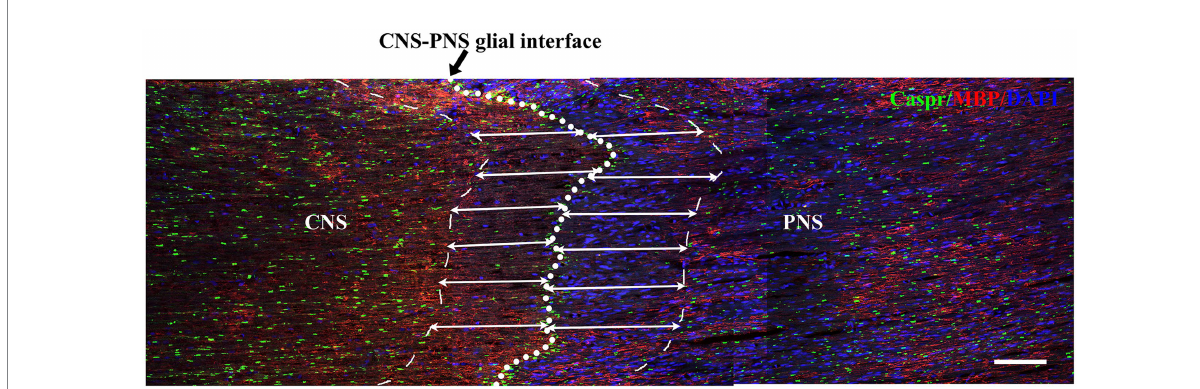
FIGURE 3 Distribution of nodes of Ranvier in the TREZ of rats. MBP (red) was mainly distributed in oligodendrocytes in the CNS, while a small amount was expressed in some Schwann cells in the PNS. Caspr (green) immunofluorescence staining showed the paranodal region of myelinated nerve fibers. The white circle dotted line (black arrow) indicates the CNS-PNS interface, where the nodes of Ranvier were highly concentrated, while the thin dotted lines show the border of node-depleted zones on both sides. The straight lines with arrows represent the distance from the boundary of the node-depleted zones to the CNS-PNS interface. Bar = 100 μ m. Logical size, X = 2048 pixels, Y = 2048 pixels, Z = 1 pixel, pixel size = 0.284 μ